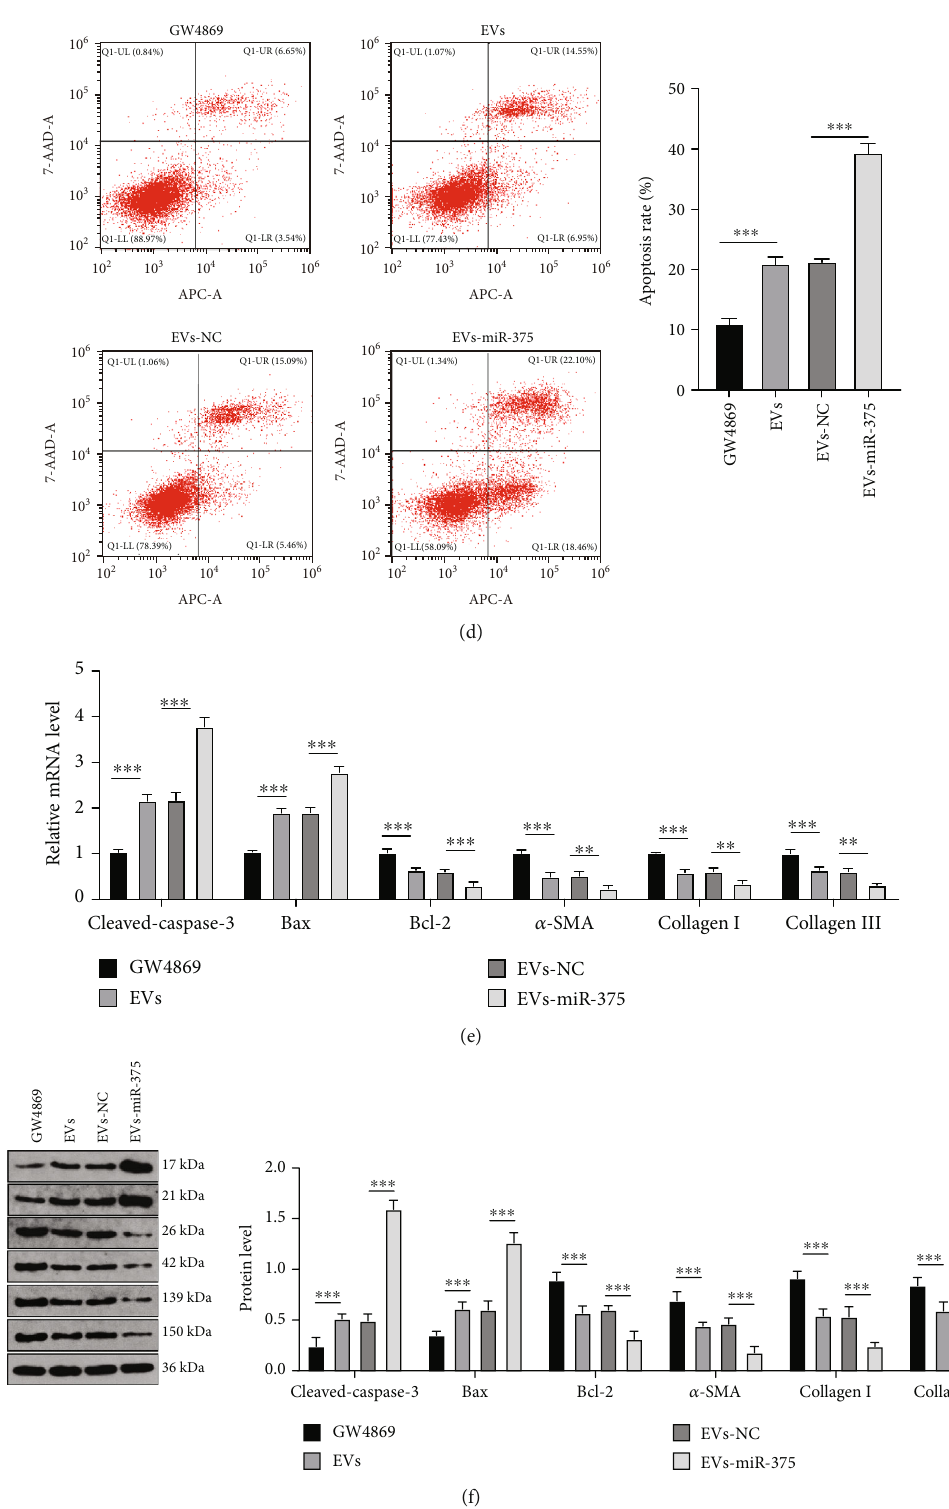
Figure 4: miR-375-overexpressed ADSC-EVs inhibit the fi brosis of fBMFs. fBMFs were treated with EVs or miR-375-overexpressed ADSC- EVs (EVs-miR-375) or the corresponding controls. (a) The proliferation of fBMFs was detected using CCK-8 assay. (b, c) The migration and invasion of fBMFs were detected using Transwell assays. (d) The apoptosis of fBMFs was detected using fl ow cytometry. (e, f) Levels of proapoptotic proteins (cleaved-caspase-3 and Bax), antiapoptotic protein Bcl-2, and fi brosis markers ( α -SMA, collagen I, and collagen III) were detected using RT-qPCR and WB. The experiment was repeated 3 times, and the data were expressed as mean ± SD . Comparison among groups was analyzed using one-way ANOVA, followed by Tukey ’ s multiple comparisons test. ∗∗ P < 0 : 01 and ∗∗∗ P < 0 : 001